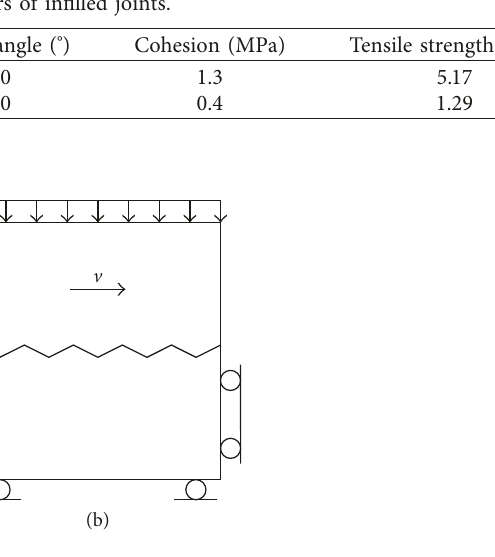
Figure 3: Direct shear tests under (a) CNS and (b) CNL